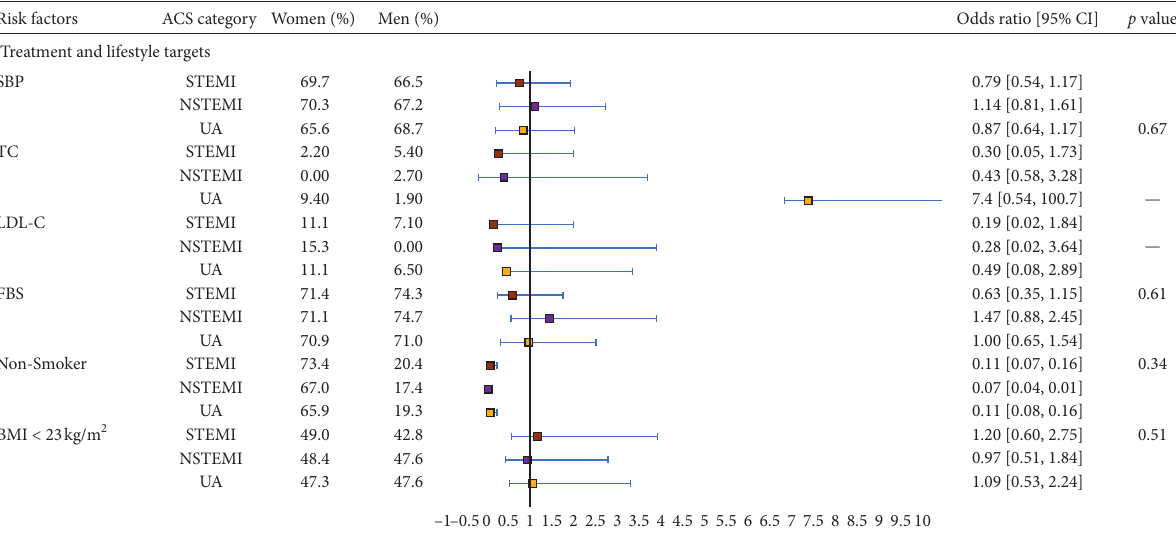
Figure 2: Age-adjusted sex differences in lifestyle factor management, stratified by the types of acute coronary syndrome. Odds ratios (95% CI) are presented as women versus men; p values are for interaction between subgroups. STEMI, ST elevation myocardial infarction; NSTEMI, non-ST elevation myocardial infarction; UA, unstable angina; SBP, systolic blood pressure; TC, total cholesterol; LDL-C, low- density lipoprotein cholesterol; FBS, fasting blood sugar; BMI, body mass